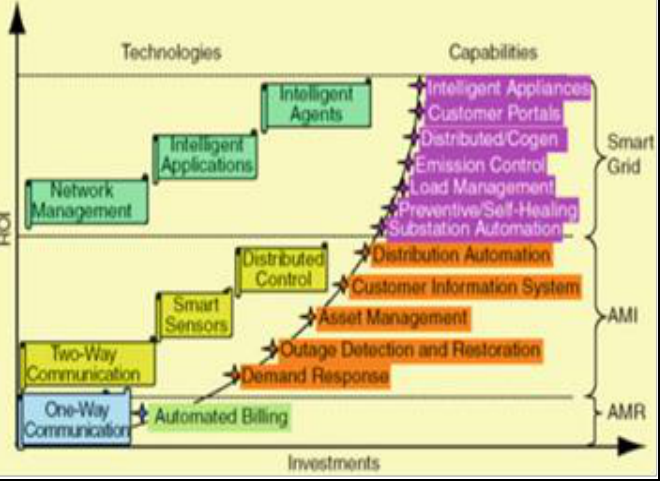
Figura 2: Arquitectura general de MSG para comunidades aisladas. Fuente: [7].